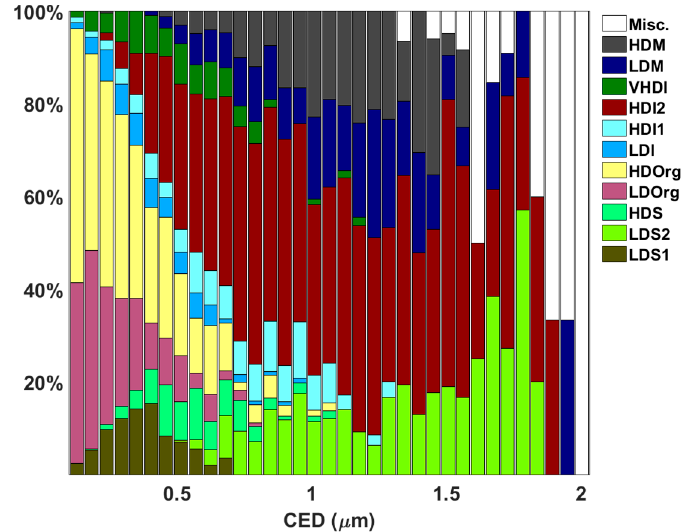
Figure 6. Cluster contribution for varying particle size. Particles >2 µm have been omitted due to their very small abundance and to highlight submicron cluster composition.